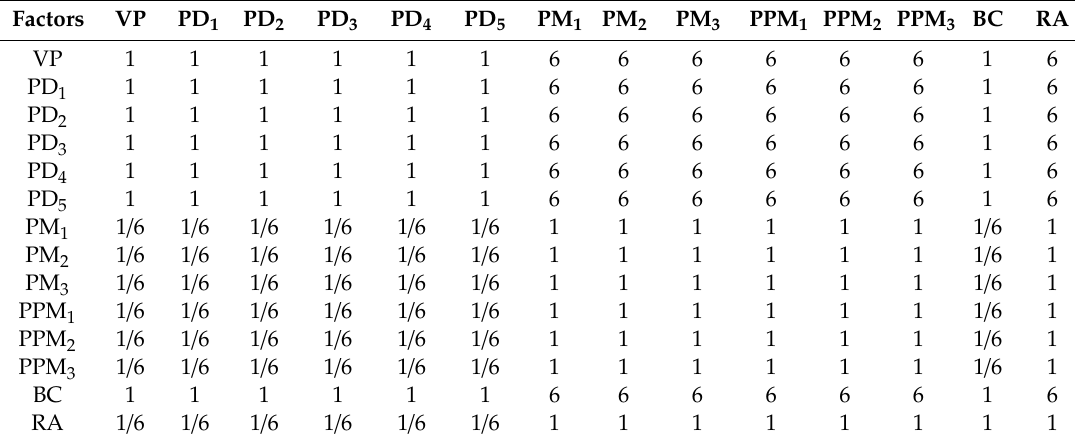
Table 9. Ability to plan the risk sub-decision factors pairwise comparison.